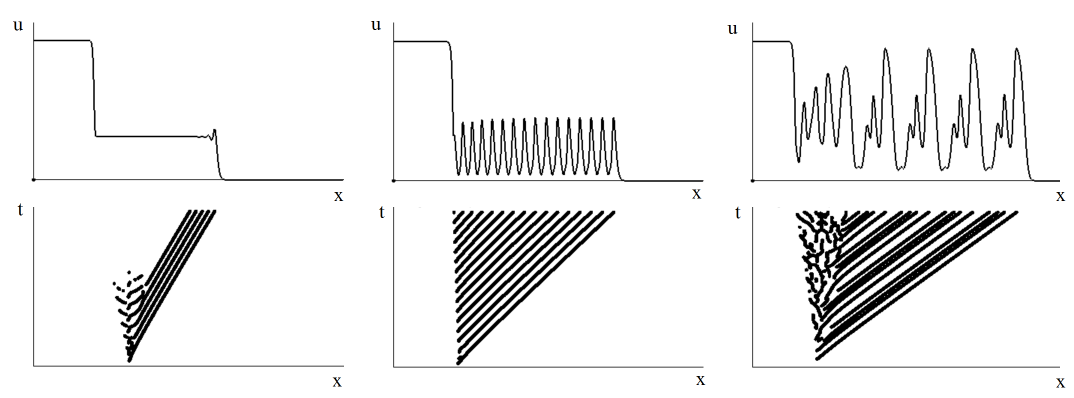
Figure 3. Snapshots of different regimes of wave propagation in numerical simulations of Equation (3) in the monostable–bistable case. The speed of the monostable wave is greater than the speed of the bistable wave, and the distance between them grows ( upper row, left ). The intermediate equilibrium between the wave becomes unstable, and the monostable wave is space periodic ( upper row, middle ). This periodic wave can be followed by complex spatiotemporal oscillations ( upper row, right ). The lower row shows the position of local maxima of the same solutions on the ( x , t ) -plane. Reprinted from [37] with